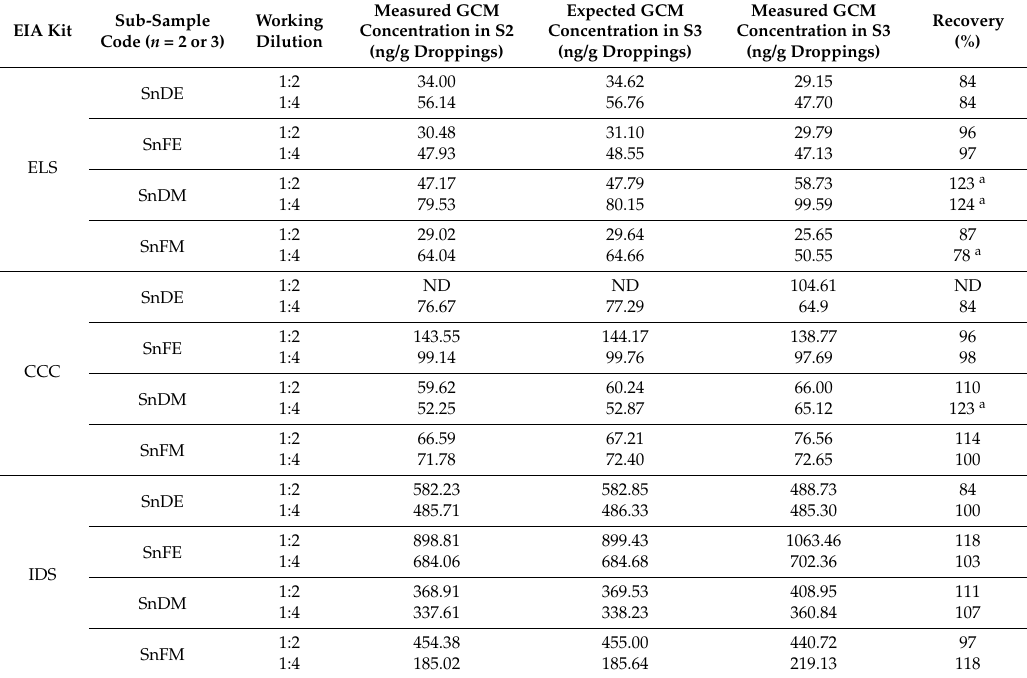
Table 5. Virtual recovery of corticosterone in African Grey Parrots’ droppings under all tested conditions.